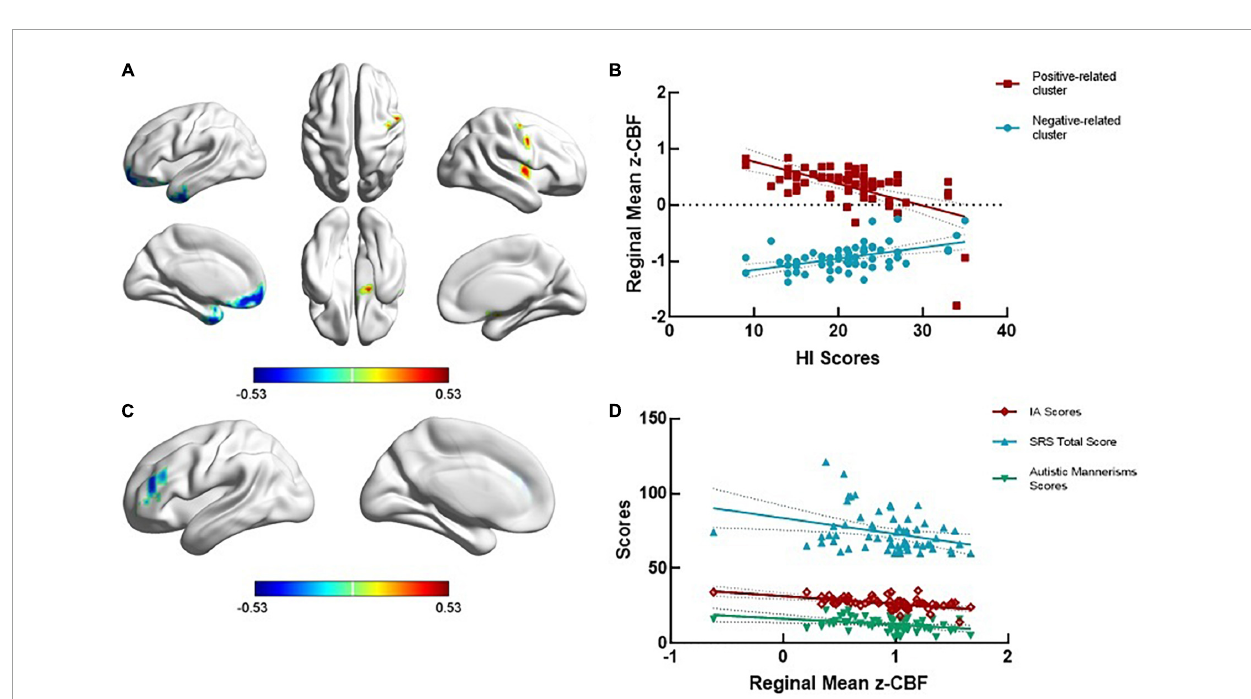
FIGURE2 ADHD-related regional cerebral blood flow in the dimensional analysis. (A,B) The regional cerebral blood flow (rCBF) was negatively related to ADHD-RS-IV HI scores in the left temporal pole ( r = —0.528, GRF corrected voxel P < 0.01) and positively related to ADHD-RS-IV HI scores in the right precentral gyrus ( r = 0.549, GRF corrected voxel P < 0.01). (C) The rCBF value was negatively related to the ADHD-RS-IV IA scores in the left middle frontal gyrus ( r = —0.521, GRF corrected voxel P < 0.01). (D) The mean rCBF in the left middle frontal gyrus was negatively correlated with SRS total scores ( r = —0.321, P = 0.012) and autistic mannerisms scores ( r = —0.358, P = 0.005) in the ADHD + SD